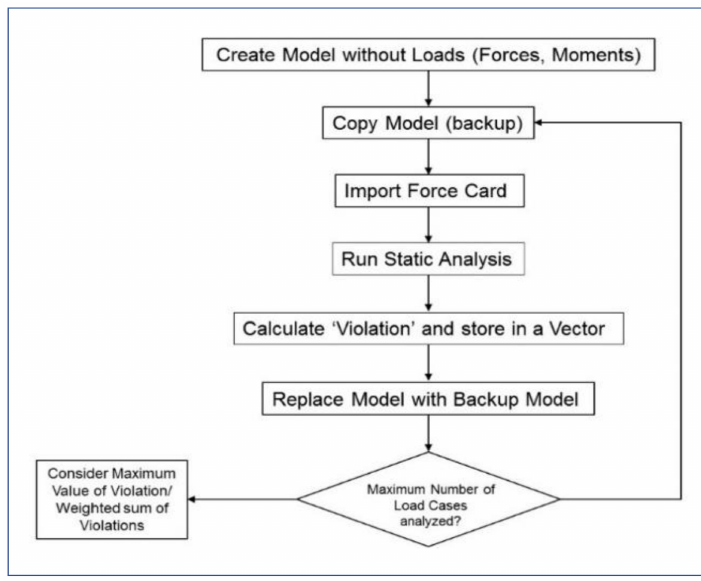
Figure 14. Process of calculating ‘Violation’ for multiple load